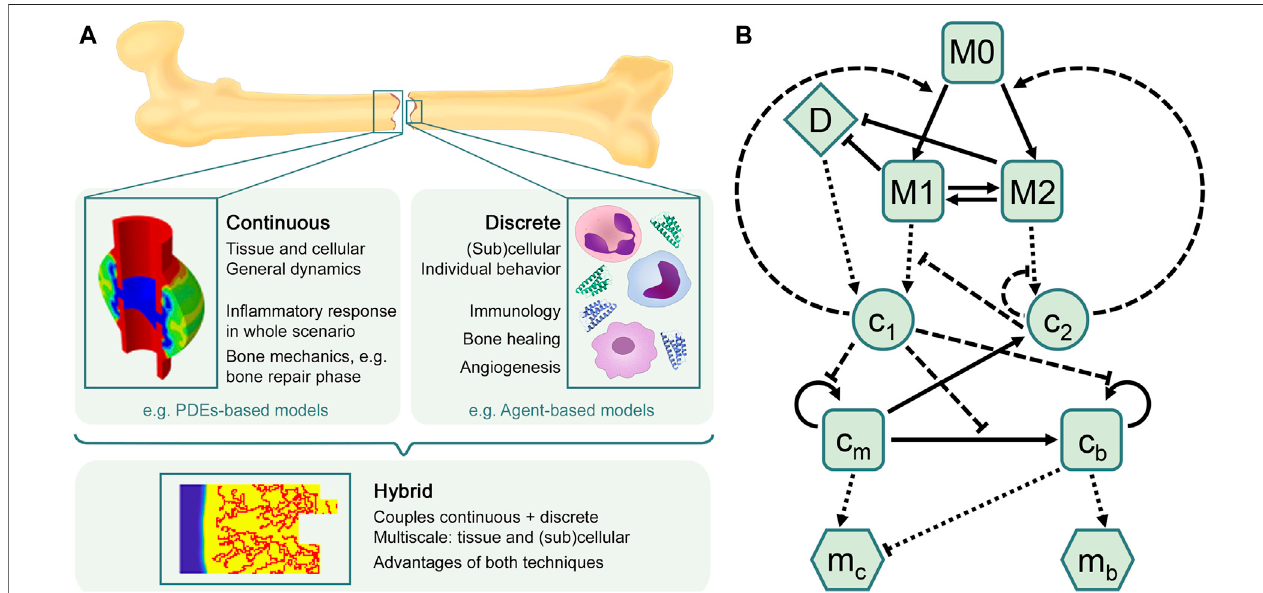
FIGURE 2 | In silico approaches to model the bone healing process and the in fl ammatory response. (A) Overview of in silico techniques to describe biological processes and predict their different outcomes. The choice of the in silico model depends on the research goal. Continuous models are often used to describe general dynamicsattissueandcellularscales,suchasbonemechanics,inwhichdifferenttissuematricesinterplay( fi gureadaptedfromWangandYang,2018).Discretemodelsare mostly used to represent individual behavior at (sub)cellular scales, such as the immune response, which comprises a high number of cells and cytokines. The hybrid approachcombinestheadvantagesofbothcontinuousanddiscretetechniques,providingcomprehensivemultiscalemodelsthatallowtoinvestigate,forinstance,sprouting angiogenesis during the bone regeneration process ( fi gure obtained with the model described in Carlier et al., 2016). (B) Flow diagram summarizing the macrophage- mediatedin fl ammationinbonefracturehealingdescribedinTrejoetal.(2019).Cellsarerepresentedbysquares:unactivatedmacrophages(M 0 ),classicalmacrophages(M 1 ), alternative macrophages (M 2 ), SPCs (c m ) and osteoblasts (c b ). Pro-in fl ammatory (c 1 ) and anti-in fl ammatory (c 2 ) cytokines are represented by circles. Tissue matrices are represented by hexagons: fi brocartilage (m c ) and woven bone (m b ). Debris (D) is represented by a diamond. Adapted from Trejo et al. (2019).